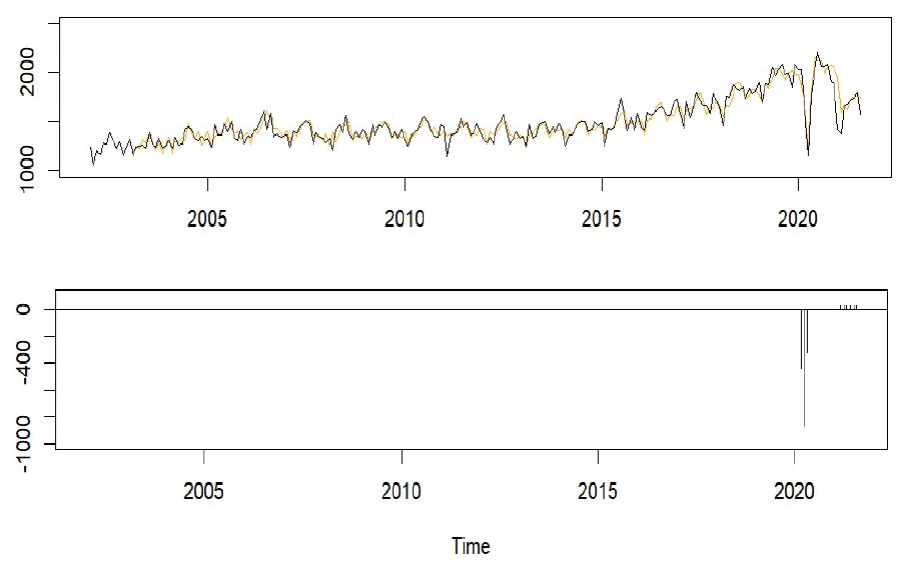
Figure 7. Kidney donor transplant counts with the model fit ( top ) and the estimated COVID-19 effects ( bottom